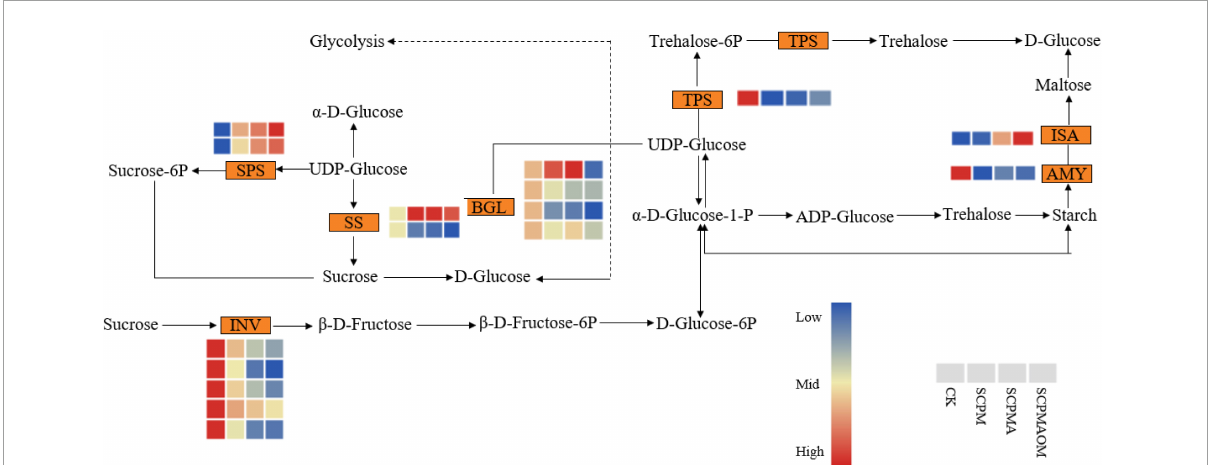
FIGURE8 Differentially expressed genes related to the starch and sucrose metabolism pathways in the different treatments. Red color denoted genes with high expression level, while blue color denoted genes with low expression level. The relative expression levels of DEGs were calculated using the log2 ratio.